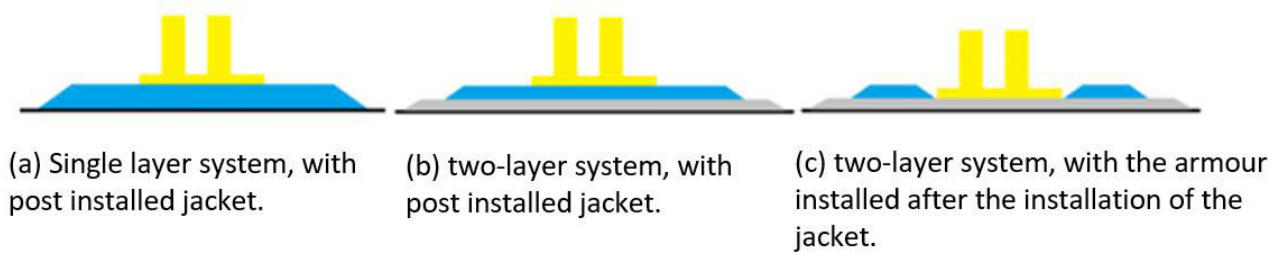
Figure 4. Configurations studied in physical modelling of Reference [77] for 4-legged structure at Hollandse Kust Zuid (HZK) Offshore wind